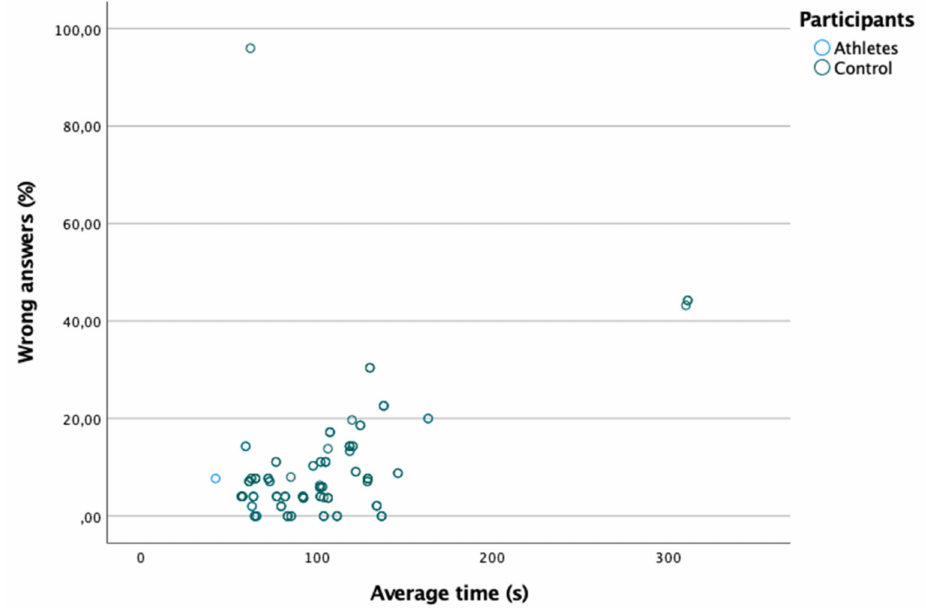
Figure 4. Positive linear relationship between the percentage of wrong answers and the average